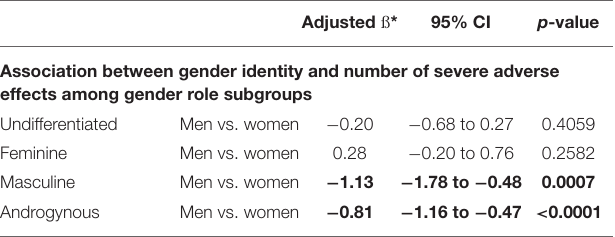
TABLE 4 | Gender-stratified multivariable results.